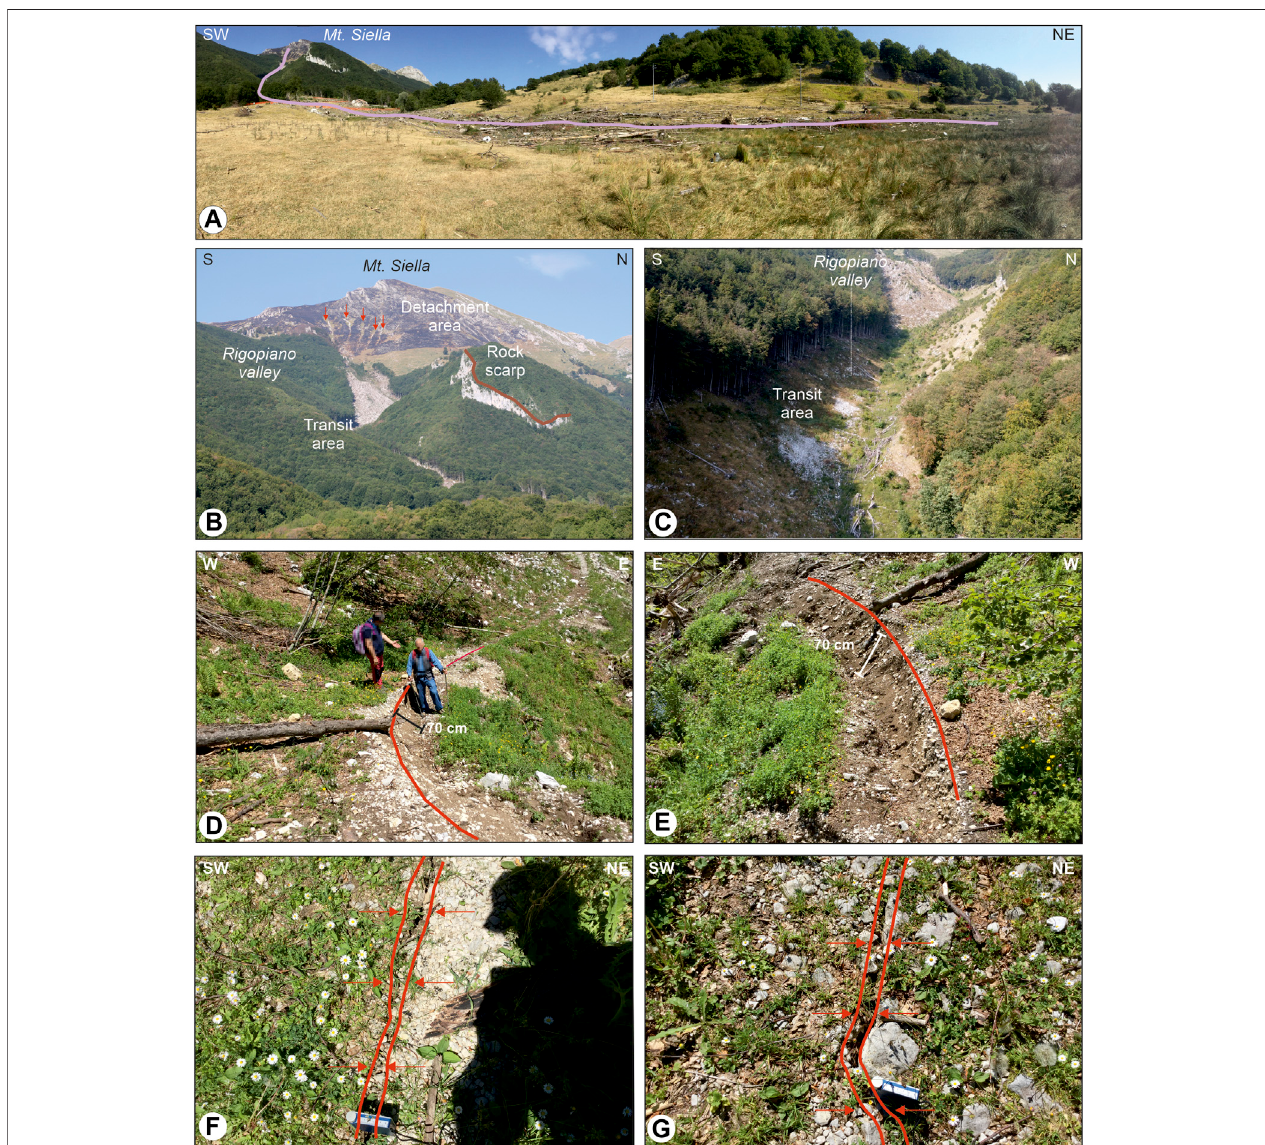
FIGURE11| Geomorphologicallandforms inthe Rigopianoarea: (A) View oftheRigopiano valley fromMt. Siella totheRigopianoplain (where the2017avalanche occurred, approximately indicated by the pink line). (B) Eastern Mt. Siella slope and Rigopiano V-shaped valley; the detachment and the transit area of the 2017 avalanche were evidenced, as well as a steep rock scarp on the northern side of the valley; the whitish striae (red arrows) in the detachment area are debris fl ows. (C) Rigopiano V-shaped valley and transit area of the 2017 avalanche. (D) Upper Rigopiano valley (1,535 m a.s.l.); scarp con-nected to the co-seismic shaking and avalanche triggering. (E) Upper Rigopiano valley (1,535 m a.s.l.); close up of the scarp connected to the co-seismic shaking and the avalanche triggering. (F) NE side of the Mt. Siella (1,465 m a.s.l.); co-seismic fracture 3 – 5 cm open. (G) . NE side of the Mt. Siella (1,510 m a.s.l.); co-seismic fracture 2 – 3 cm open. The location of the co- seismic fractures is depicted in Figure 12